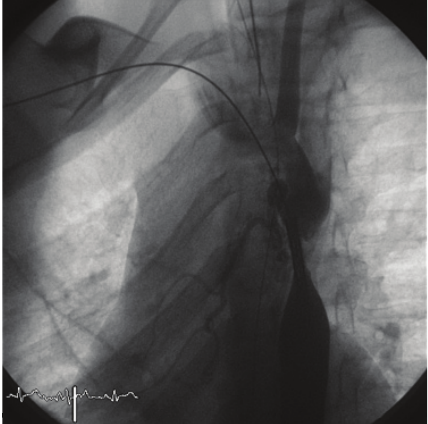
Figure 1: Anteroposterior view: severe aortic coarctation.